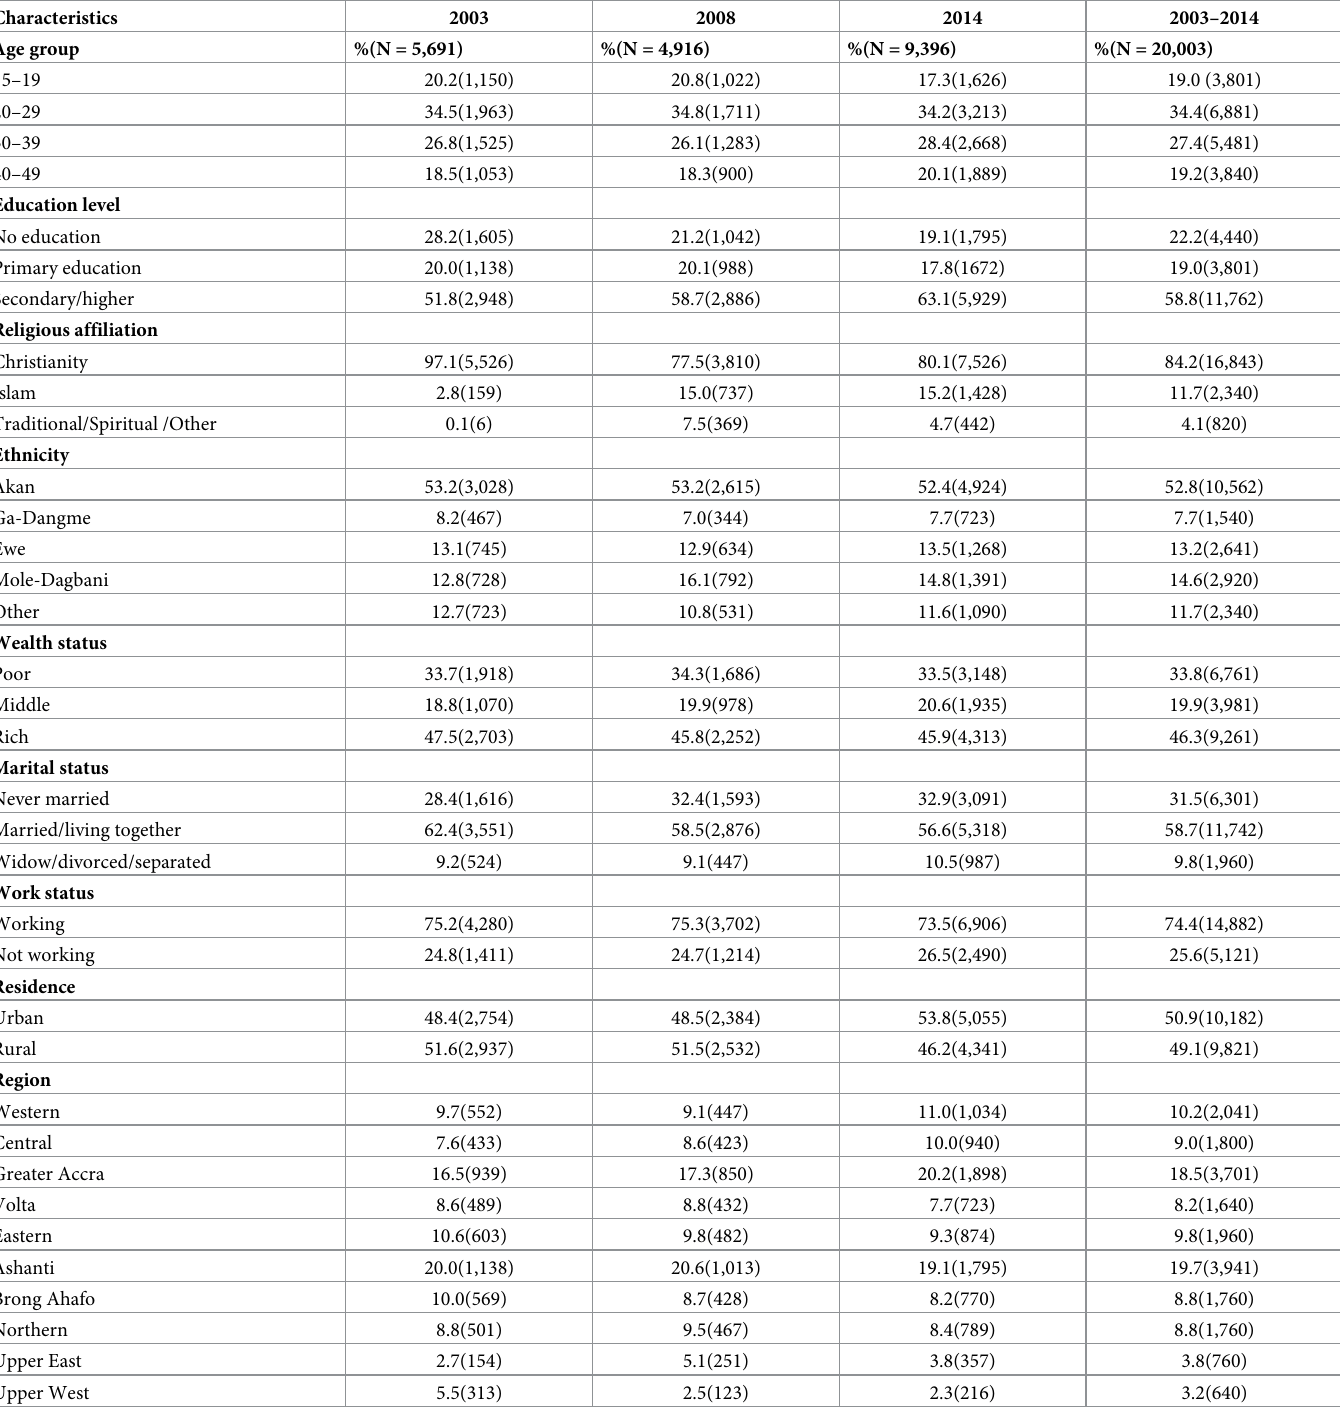
Table 1. Percentage of the sample by background